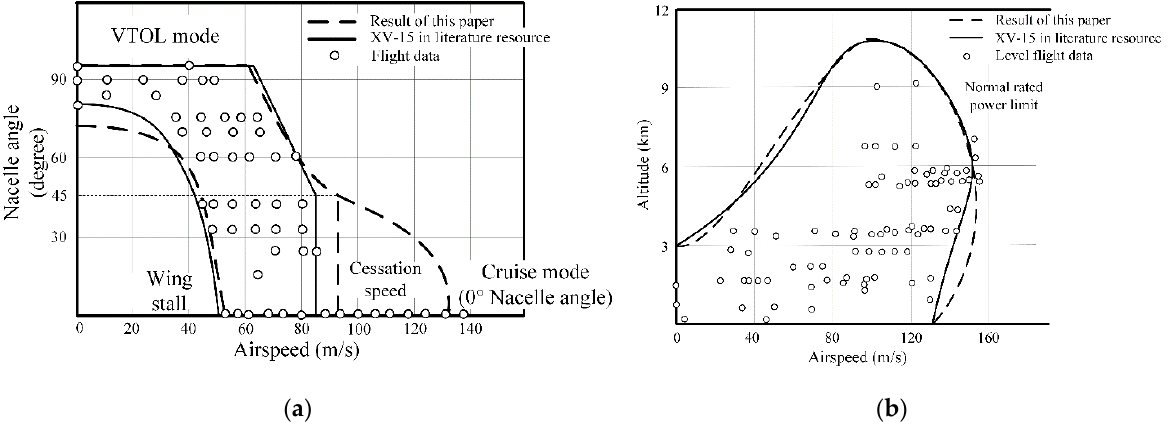
Figure 9. Comparisons between the XV-15 data sourced from 3D envelope and literature [29]: ( a ) conversion corridor at sea level; and ( b ) flight envelope diagram.